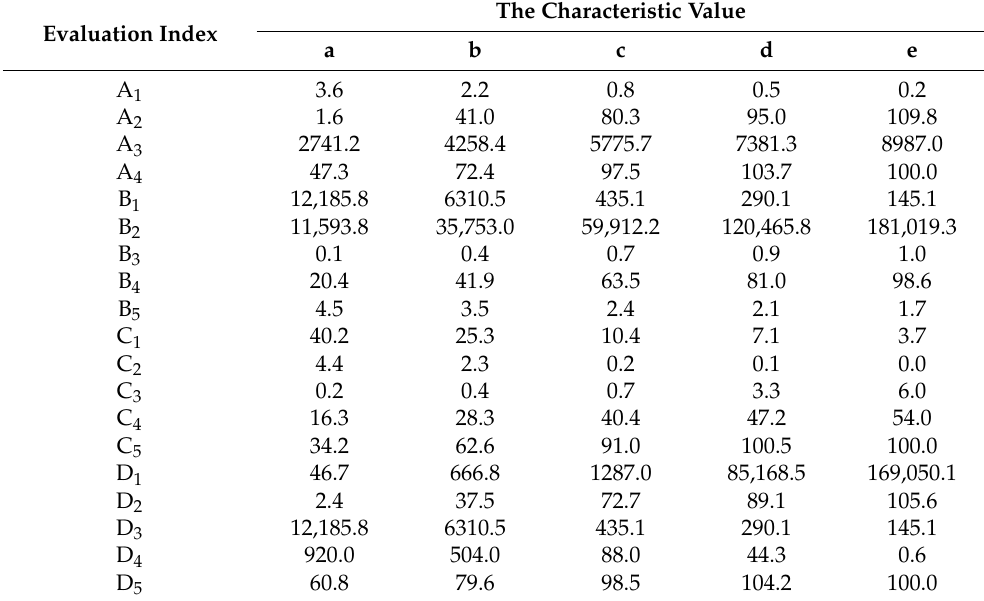
Table 2. The characteristic values of evaluation index.